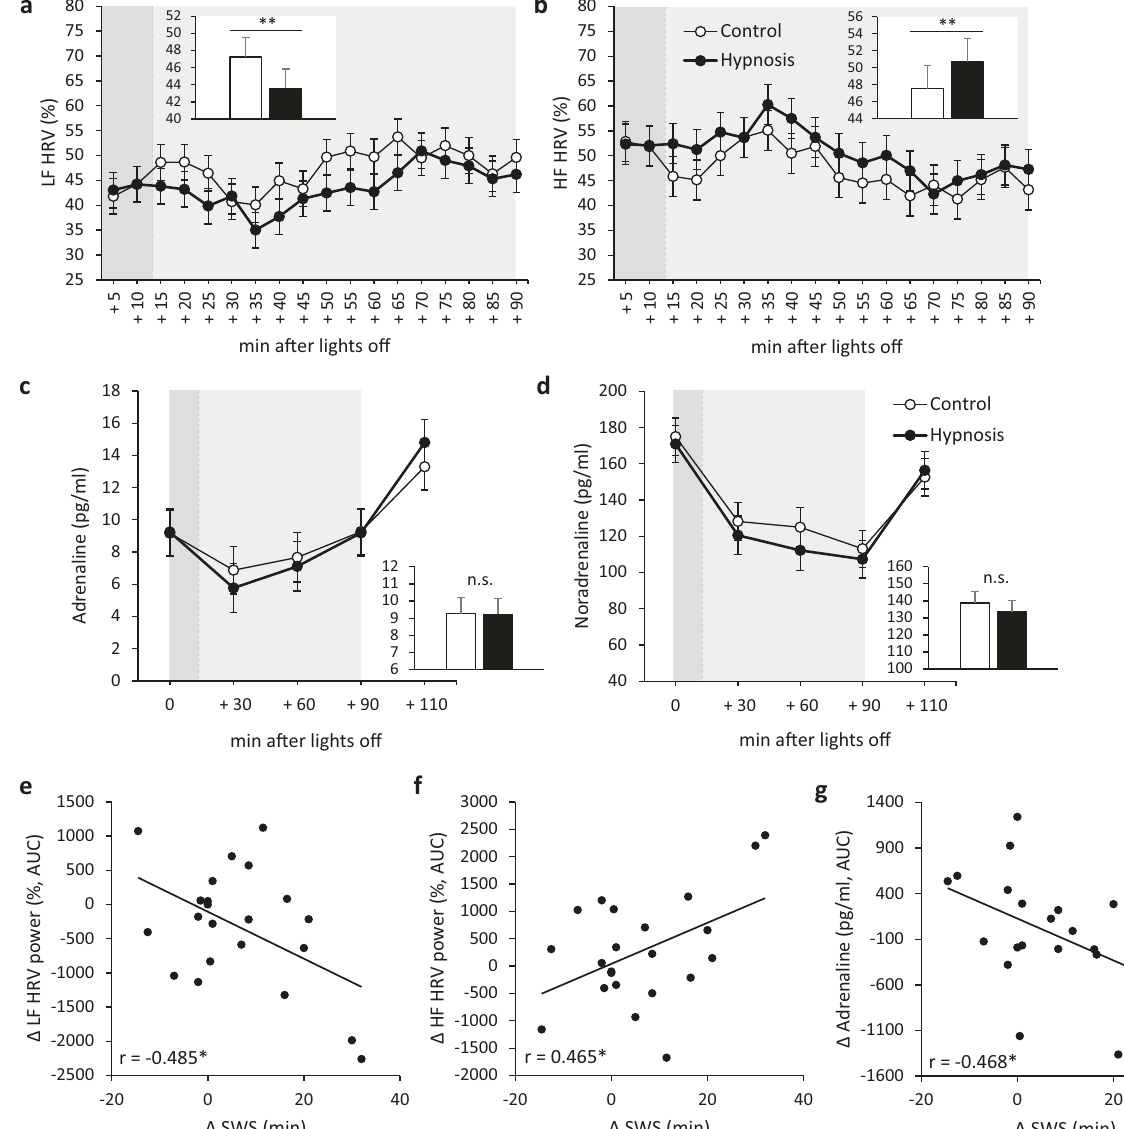
Fig. 3 Effects of hypnotic suggestions on measures of the autonomic nervous system. a – d Estimated marginal means (±SEM) of ( a ) relative low frequency power of heart-rate variability (LF HRV), ( b ) relative high frequency power of HRV (HF HRV), ( c ) adrenaline levels, and ( d ) noradrenaline levels in the Hypnosis condition (black circles) vs. the Control condition (white circles). Light gray area indicates nap time, darker gray area within nap time indicates duration of the audio tape. e – g Correlations of changes in SWS duration in the Hypnosis relative to the Control condition with ( e ) changes in relative LF HRV power, ( f ) changes in relative HF HRV power, and ( g ) changes (in the area under the curve, AUC) of adrenaline levels. ** p < 0.01, * p < 0.05 for the Condition main effect of the linear mixed models analyses shown in the insets and for the correlation coef fi cients; n.s. not signi fi cant; n =